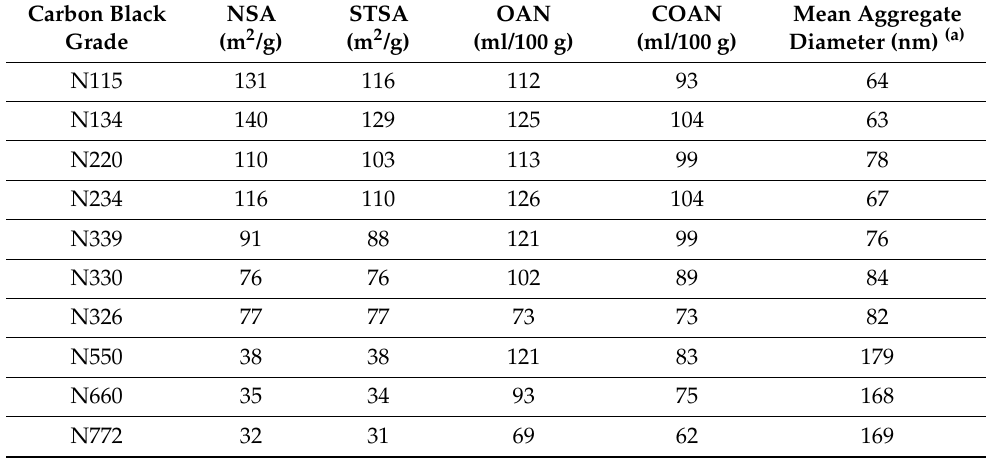
Table 3. Surface Area and Structure Characteristics of Various Furnace Grades of CB for Rubber. Carbon Black